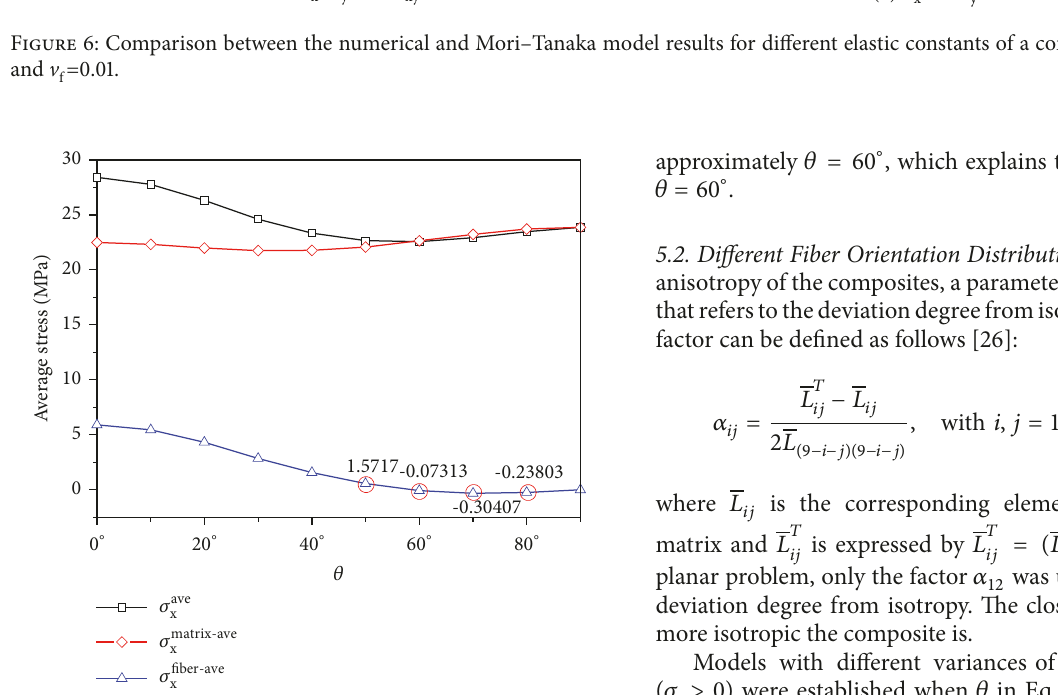
Figure 7: Average stress of the total model, matrix, and fibers of a composite with 𝑙 f =1 mm and V f =0.01 when the uniaxial tension of the x direction is